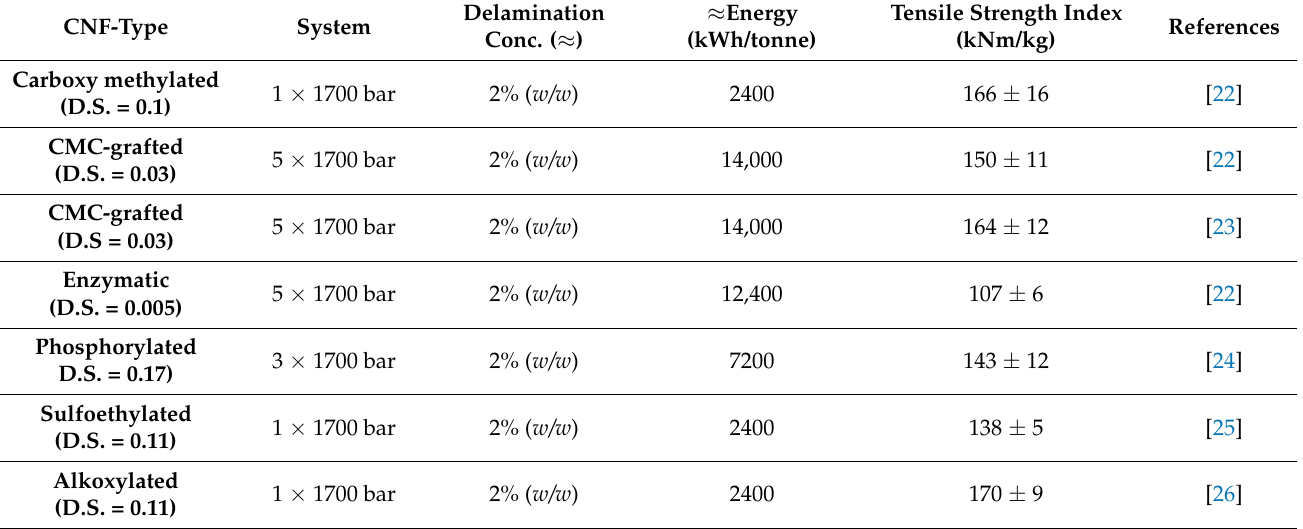
Table 2. The different nanocellulose materials used, delamination conc., tensile index at a certain delamination conc., and the original refences, from which the data have been